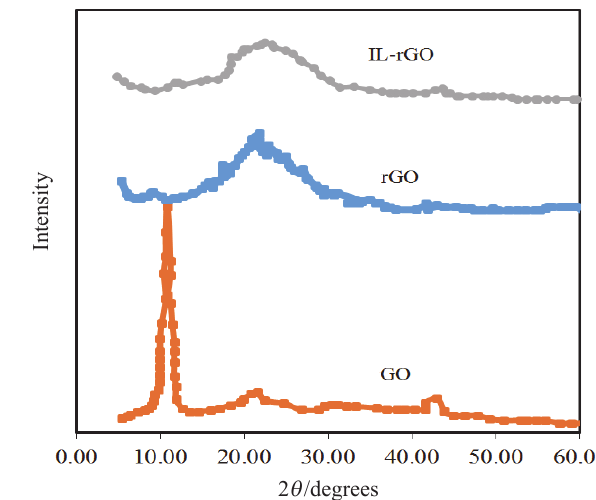
Fig. 2- Fig. 2 – XRD patterns of graphene oxide, reduced graphene